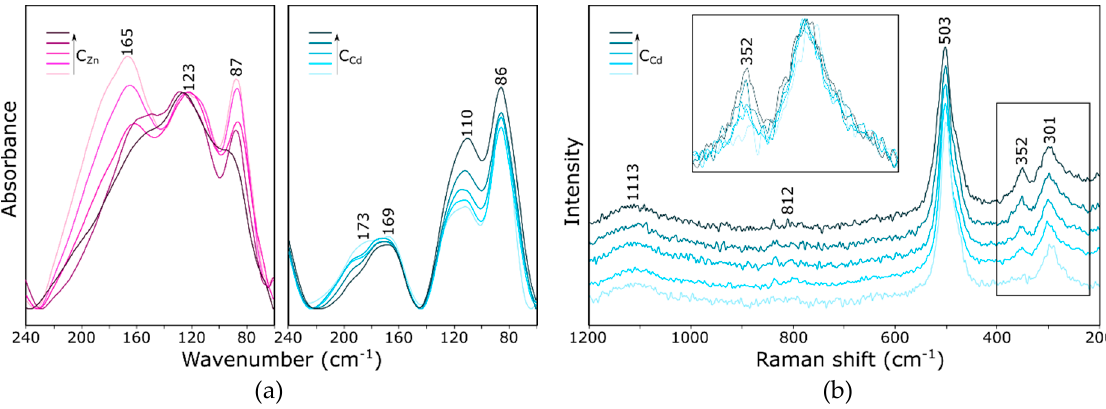
Figure 6. FTIR ( a ) and Raman ( b ) spectra of zeolite Y with varying degrees of Na + by Zn 2+ or Cd 2+ substitution.